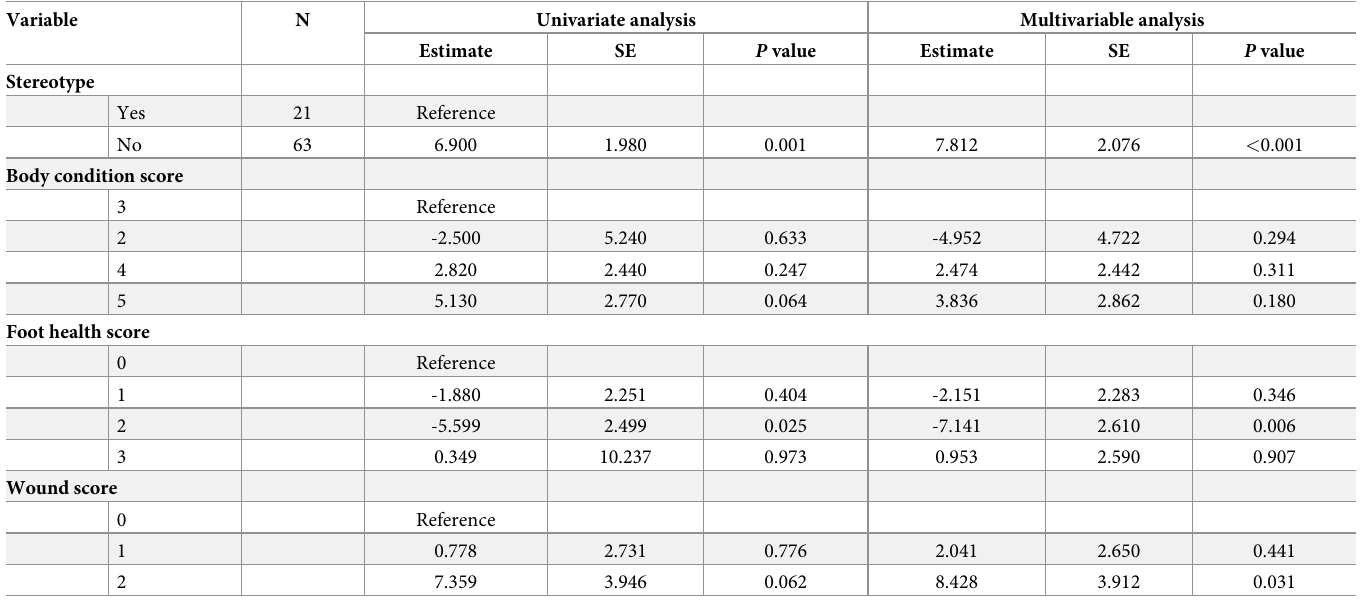
Table 6. Univariate and multivariable GEE analyses of stereotypic behaviors, BCS, FS, and WS associated with mean ( ± SEM) fecal glucocorticoid metabolite (FGM) concentrations of elephants in each category.